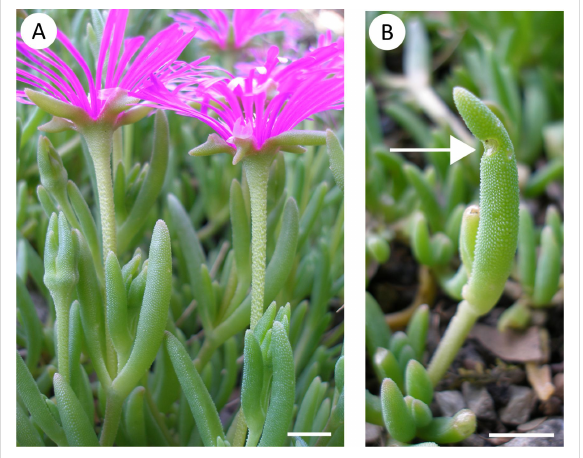
Figure 1: Delosperma cooperi. (a) Flowering plants cultivated outdoors in the Botanic Garden Freiburg, Germany. (b) Permanent kink (arrow) after wounding and finalised self-repair of a succulent leaf. Scale bars equal 5